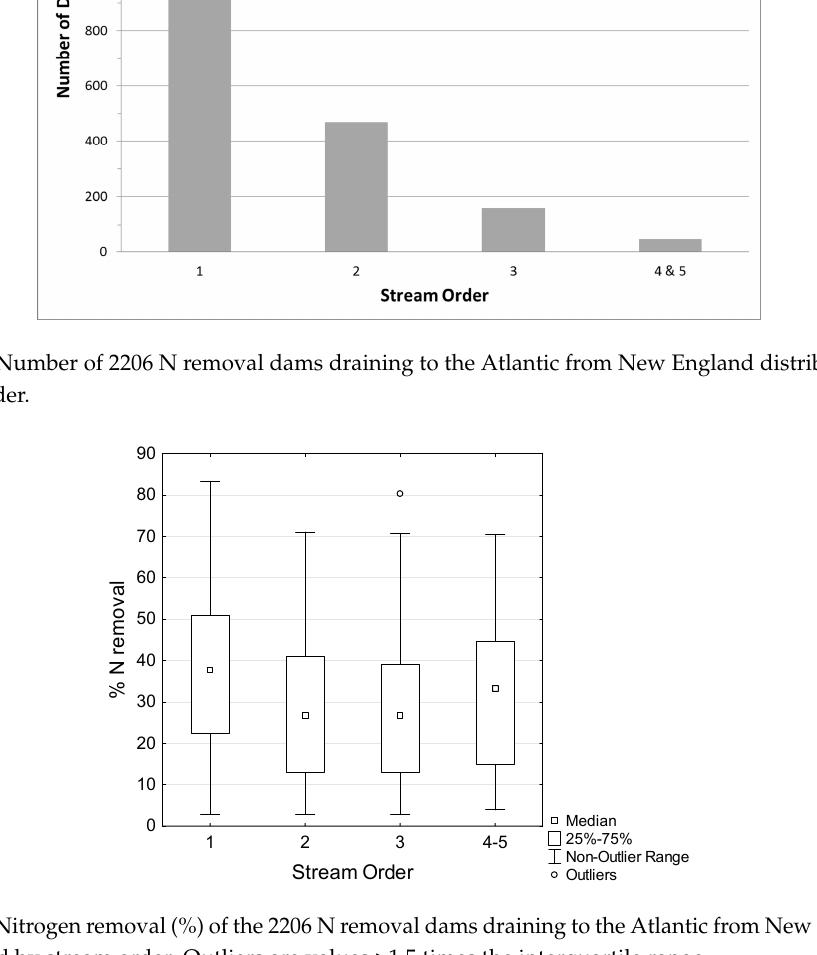
Table 3. Comparison of nitrogen loading rates for selected New England estuaries [43] to this study’s watershed nitrogen loading rates of 2206 N removal dams draining to the Atlantic from New